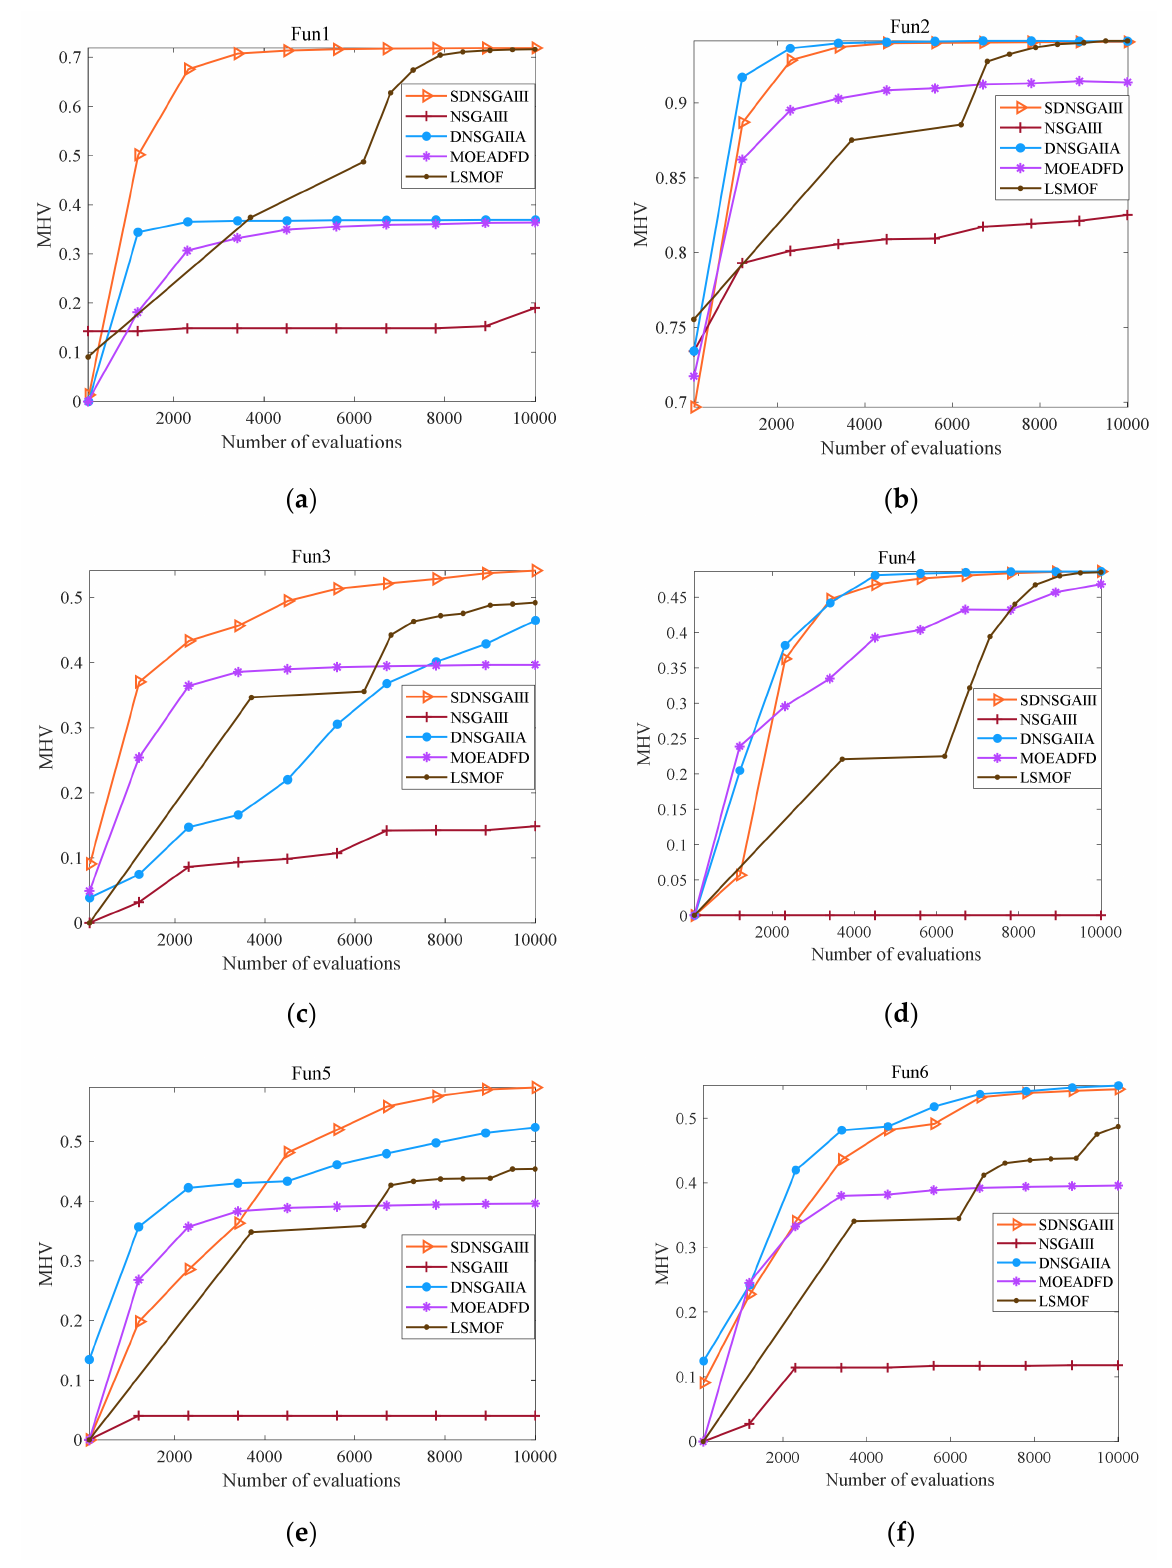
Figure 3. The MHV trend of five algorithms with n t = 10, τ T = 20. ( a – f ) are MHV trend graphs of six functions,